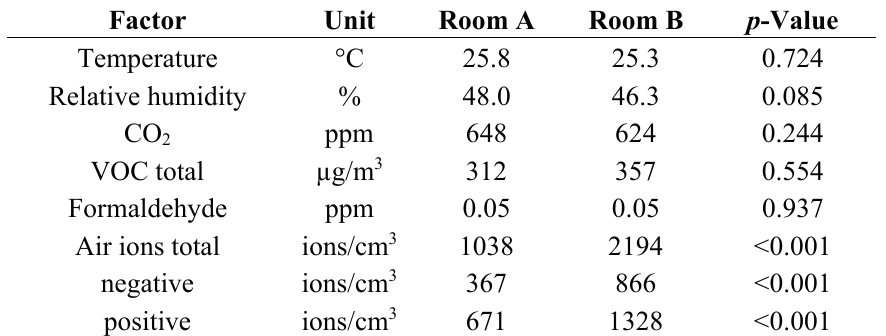
Table 1. Indoor air climate factors (temperature, relative humidity), CO 2 , volatile organic compounds (VOC), formaldehyde and air ions in rooms A and B (arithmetic means). Factor Unit Room A Room B p